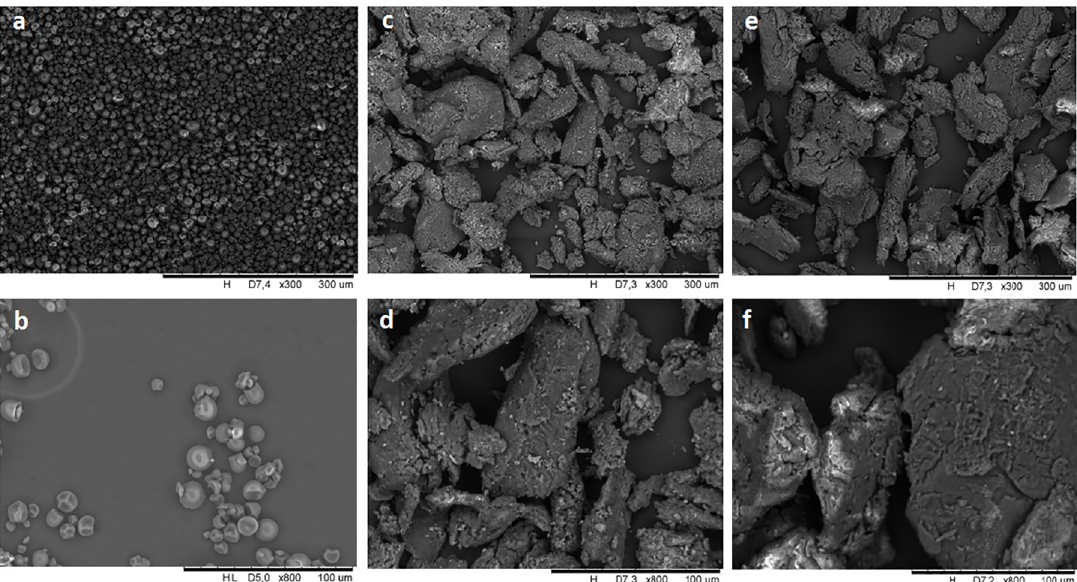
Figure 4. Micrographs with approximations of the samples (a) ST 300x (b) ST 800x (c) ST-TP 300x (d) ST-TP 800x (e) ST-TM 300x and (f) ST-TM